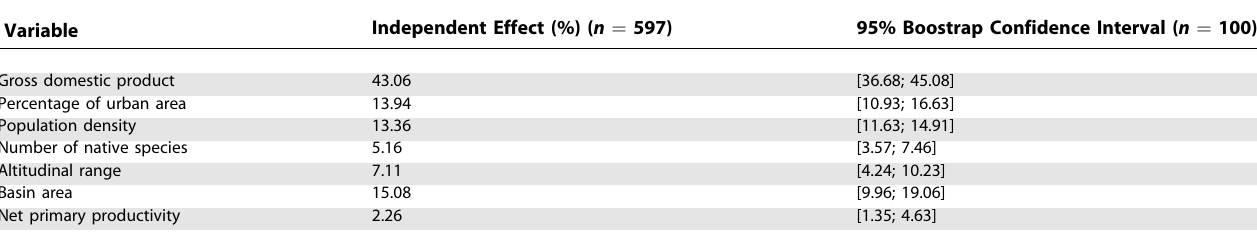
Table 2. Independent Effect of Each Environmental and Human Activity–Related Variable on the Number of Non-Native Species per